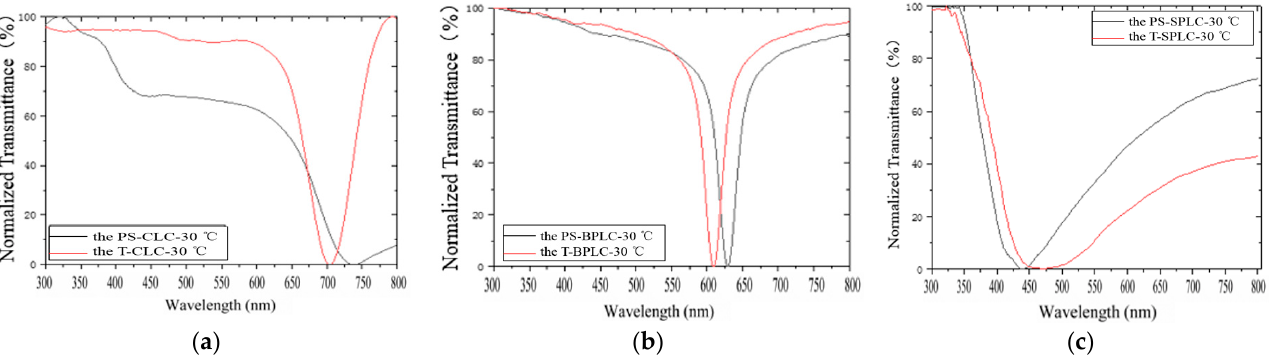
Figure 9. The reflection spectra of ( a ) the PS-CLC and T-CLC; ( b ) PS-BPLC and T-BPLC; ( c ) PS-SPLC and T-SPLC. The twist structure LCs were refilled into the CLC, BPLC, and SPLC templates to